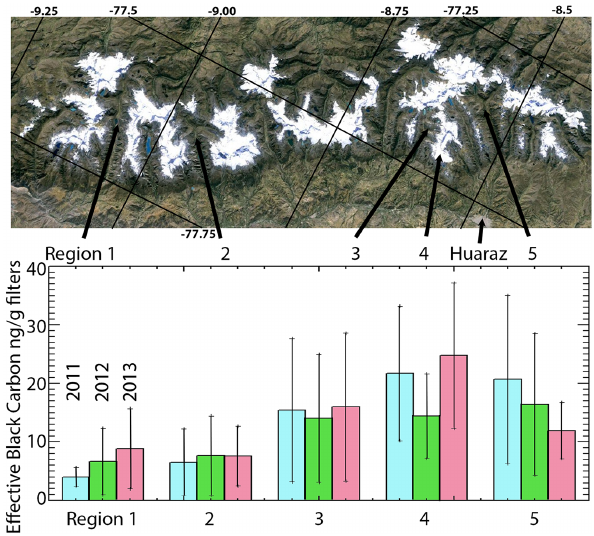
Figure 8. Google map image of the Cordillera Blanca mountain range. The five regions as well as the city of Huaraz are indicated on the map by black arrows. Average eBC values as determined from the LAHM analysis are shown in the plot for each of the 3 years. The thin lines indicate ± 1 standard deviation of the measurements. Note that in 2013, region 2, SP2 samples averaged 0.65ngg − 1 rBC indicating that most of the 8ngg − 1 of the eBC estimate could be due to light absorption by